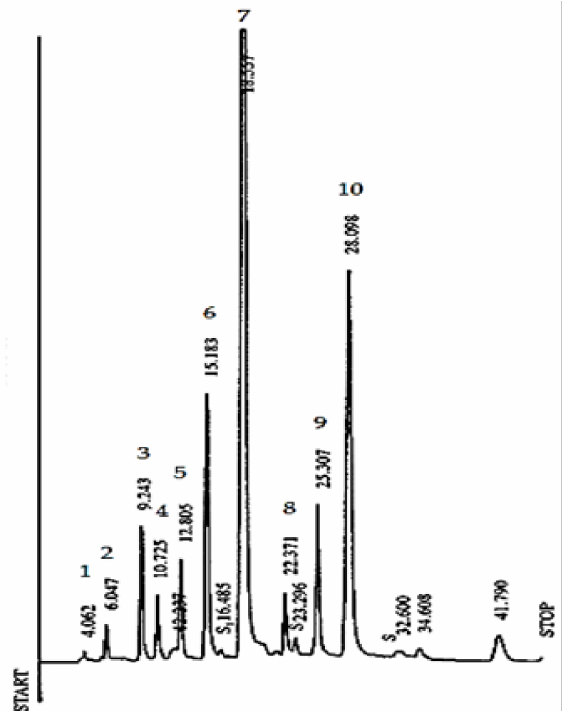
Figure 3. Reverse-phase HPLC of Azorean (Gorreana) tea catechins on a 5 µ m Spherisorb